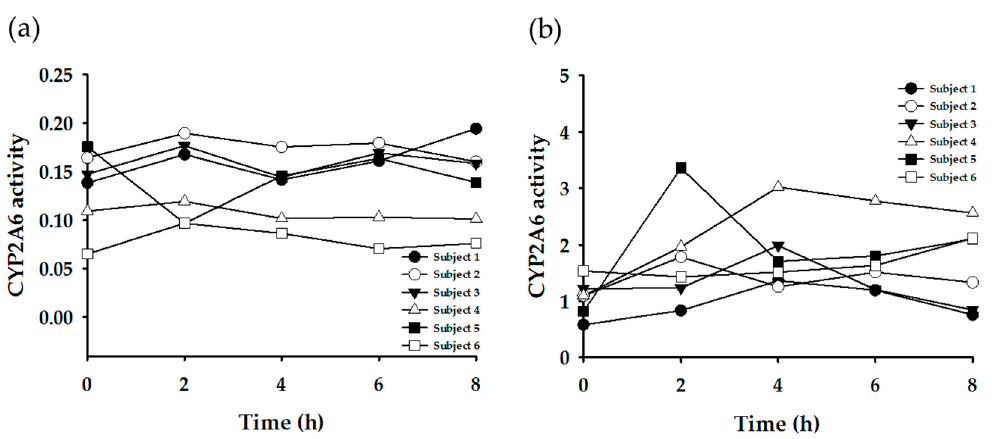
Figure 4. Plots of metabolite ratio for CYP2A6. The metabolic ratio equations used are as follows: ( a ) 17U / (AFMU + 1U + 1X + 17X + 17U), ( b ) 17X / 17U.